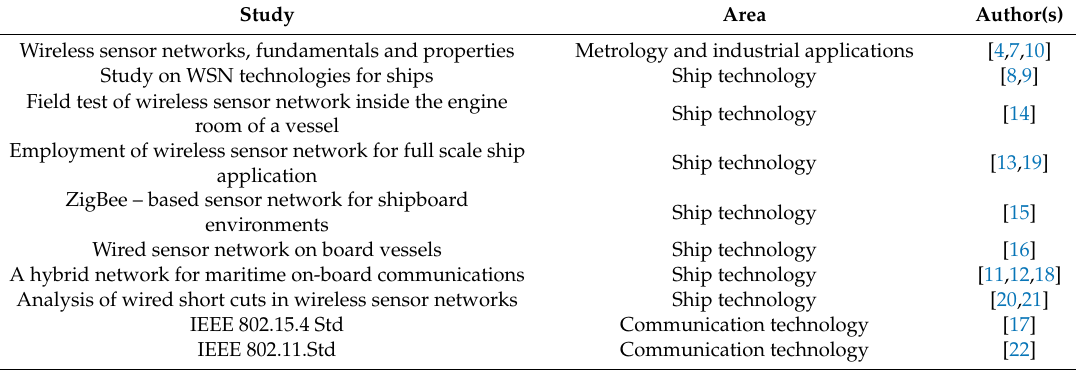
Table 1. A list of main topics, which appeared in last years in papers dedicates to issue of maritime on board communication.